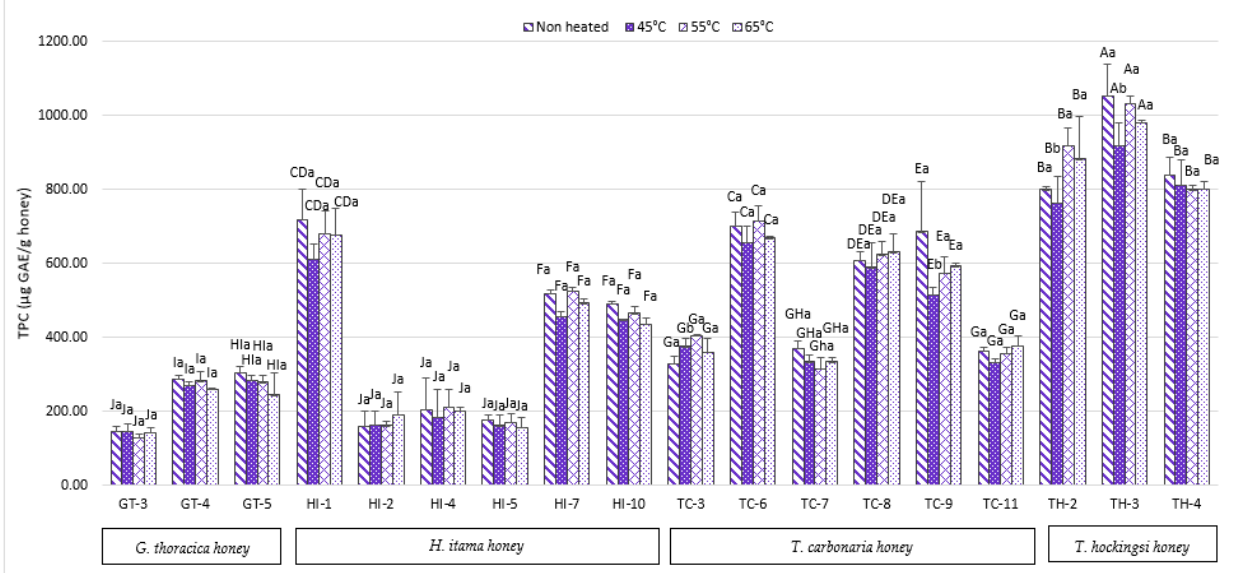
Figure 1. Total phenolic content of Malaysian and Australian stingless bee honey. The different superscripts, a and b, indicate significant differences ( p < 0.05) between the temperatures, and the different superscripts A–J indicate significant differences ( p < 0.05) between the stingless bee honeys.